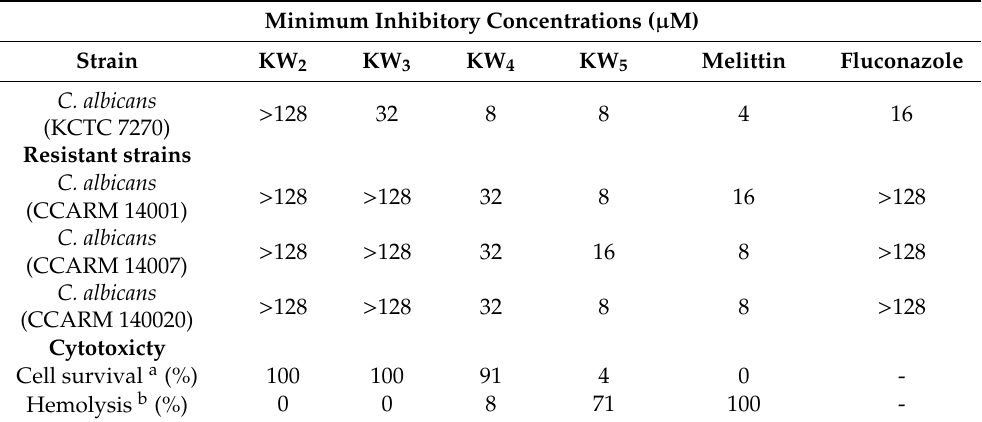
Table 1. MICs of the KW n peptides against di ff erent Candida albicans